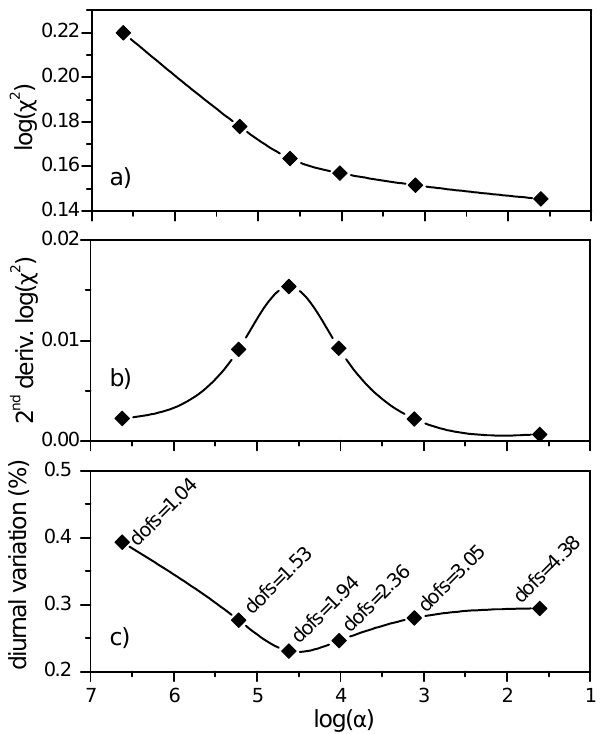
Fig. 3. Optimizing regularization strength α of Tikhonov L 1 re- trievals of CH 4 (using a diagonal measurement covariance with a signal-to-rms-noise ratio of 500) via a test ensemble of all Garmisch year 2007 measurements. (a) Mean L-curve, i.e. goodness of fit ( χ 2 ) of as a function of α . The residual term within χ 2 is the over- all rms-residual from the spectral fit and the noise term within χ 2 is calculated from the wave number interval 2615.25–2615.40cm − 1 . (b) Second derivative (curvature) of the L-curve. (c) Mean diurnal variation (1 σ ) as a function of α . Corresponding numbers for the information content (dofs) are indicated.